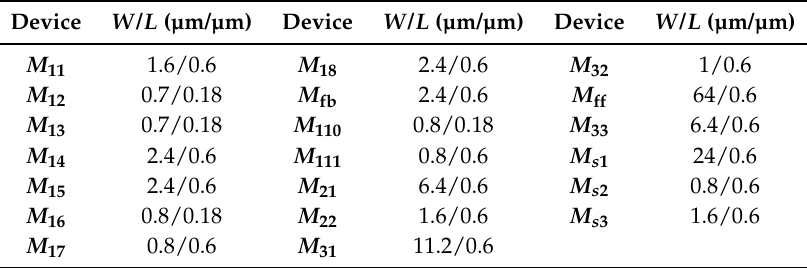
Table 9. Device sizes for the transistors in Figure 12b.